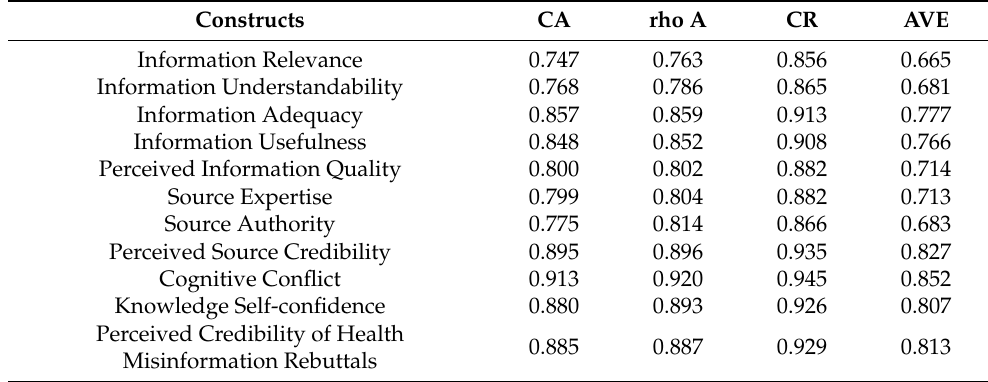
Table 3. Cronbach’s alpha (CA), composite reliability (CR), and average variance extracted (AVE).